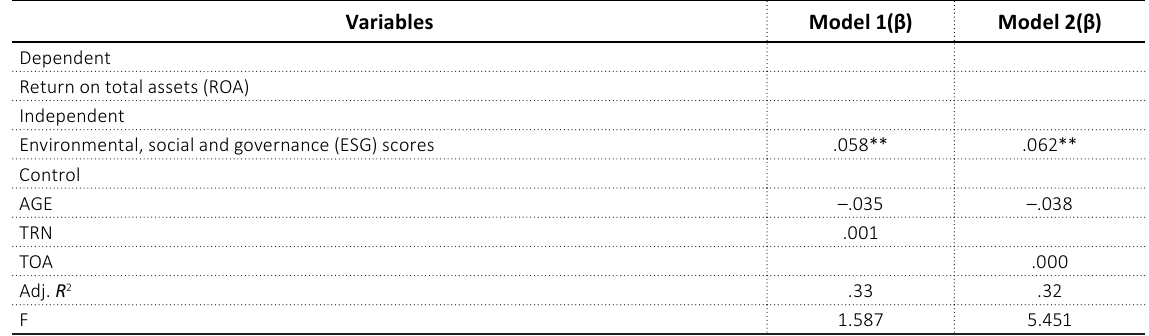
Table 5. Results of regression analysis for ESG as an independent variable (2012)